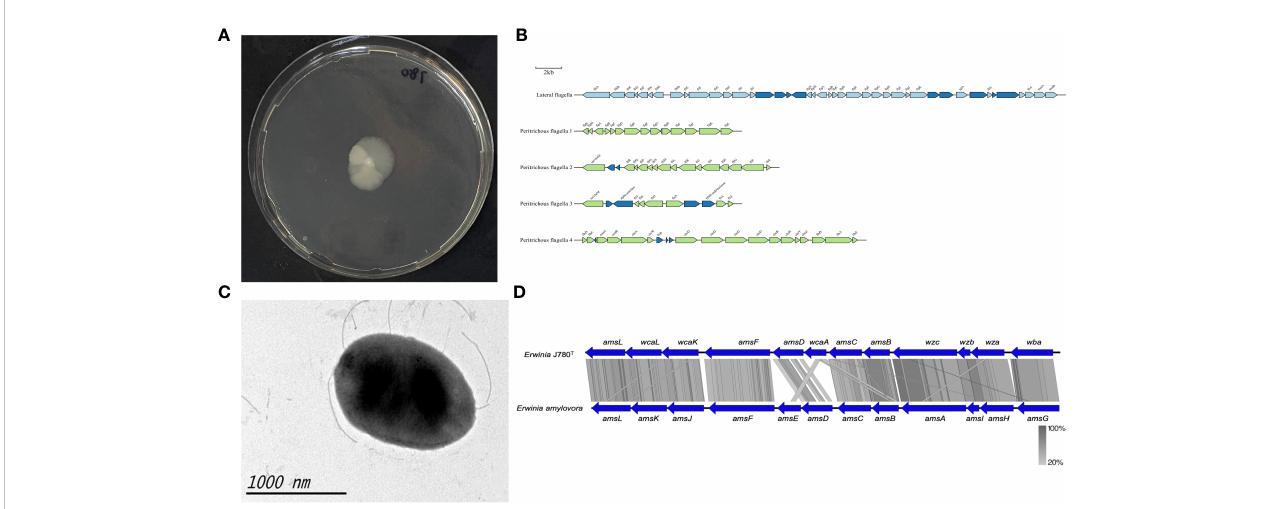
FIGURE 3 The motility and amylovoran biosynthesis genes of E. sorbitola sp. nov. (strain: J780 T ). (A) Bacterial swimming assay of the strain J780 T ; (B) schematic representation of fl agella gene clusters of the strain J780 T . Proposed gene nomenclature is shown above the corresponding ORFs (the scale bar represents 2kb); (C) transmission electron micrograph of the strain J780 T (the scale bar represents 1000nm); (D) the comparison of amylovoran biosynthesis genes between the strain J780 T and Erwinia amylovora. The fi gure was compared using BlastX and pictured with Easy fi